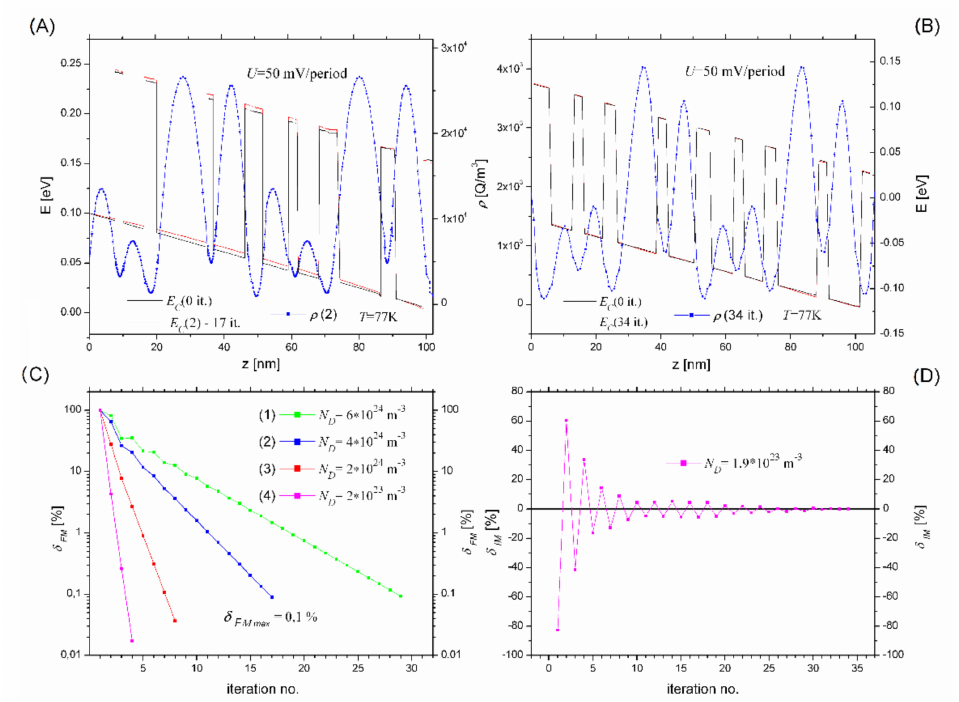
Figure 8. Results of self-consistent solution to Schrödinger and Poisson equations, i.e., distribution of total charge— ρ and potential energy— E C ) for structure 2 with bias voltage at U = 50 mV per period and the doping at the level of N D = 4 × 10 24 m − 3 obtained with FMSL (part ( A )), as well as doping at the level of N D = 1.9 × 10 23 m − 3 by means of IMSL (part ( B )). Graph ( C ) shows the dependence of the convergence coefficient— δ FM on the iteration number. The individual series in the chart refer to a different doping of the SL structure. Graph ( D ) displays the dependence of the convergence coefficient δ IM on the iteration number for the structure doping at the level of N D = 1.9 × 10 23 m − 3 . All the computations were performed for the temperature T = 77